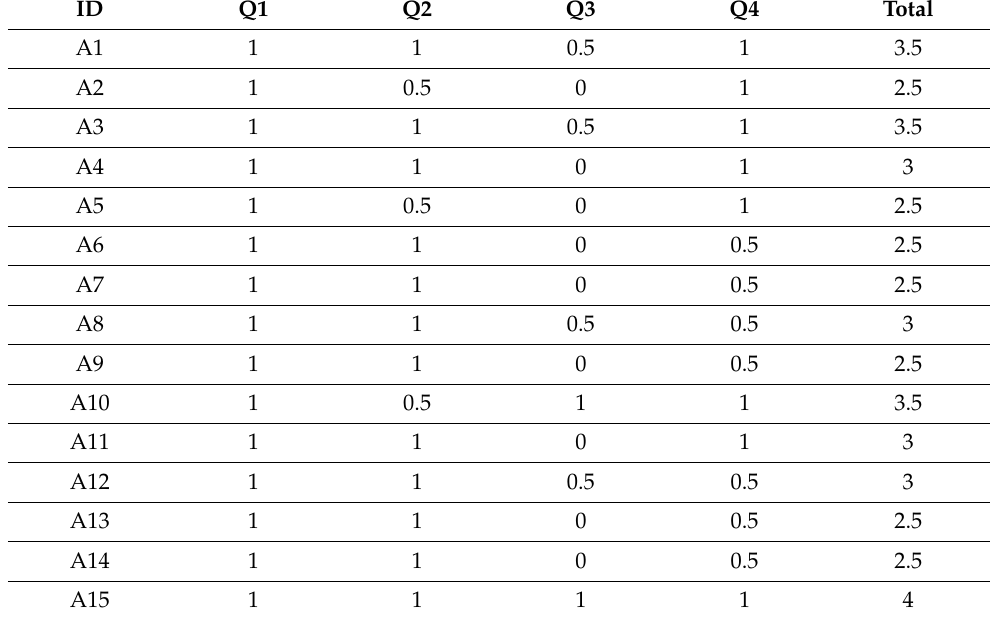
Table 5. Quality assessment